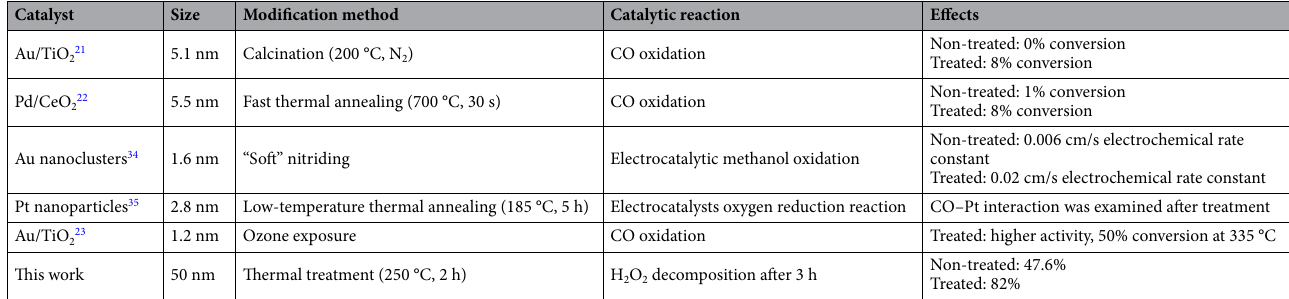
Table 2. Summary of reported capping ligands removal method on the catalytic activity of nanostructures.